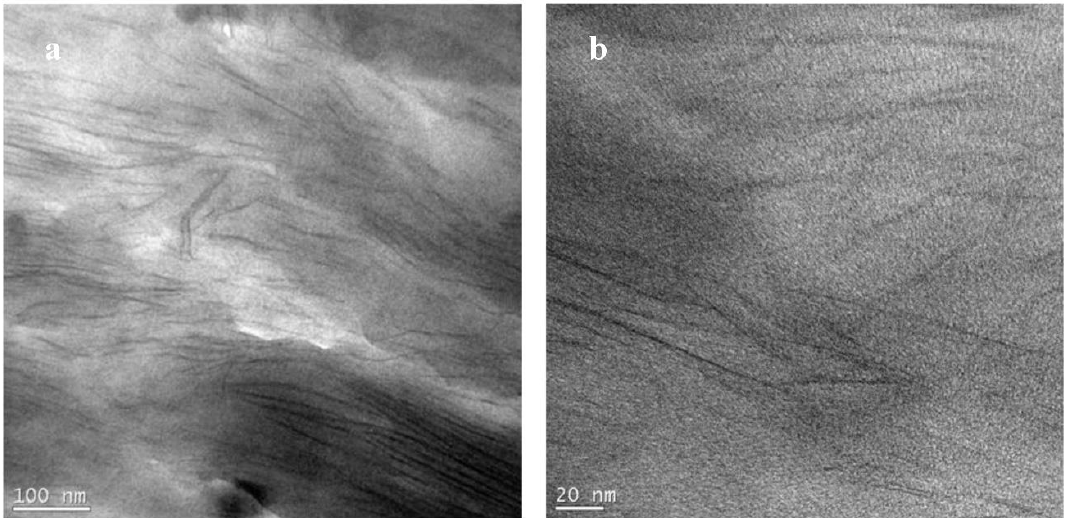
Figure 13. TEM micrographs for N6-30B prepared by static melt annealing showing evenly distributed silicate layers at low ( a ) and high ( b ) magnifications.